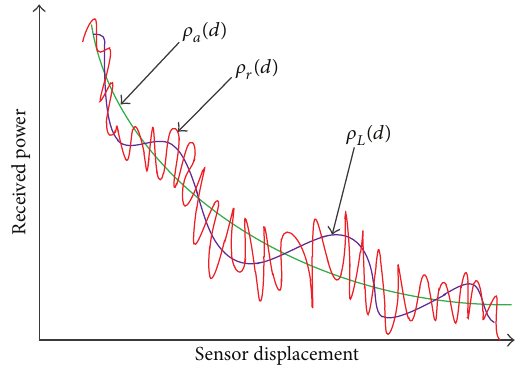
Figure 1: Shadowing and multipath